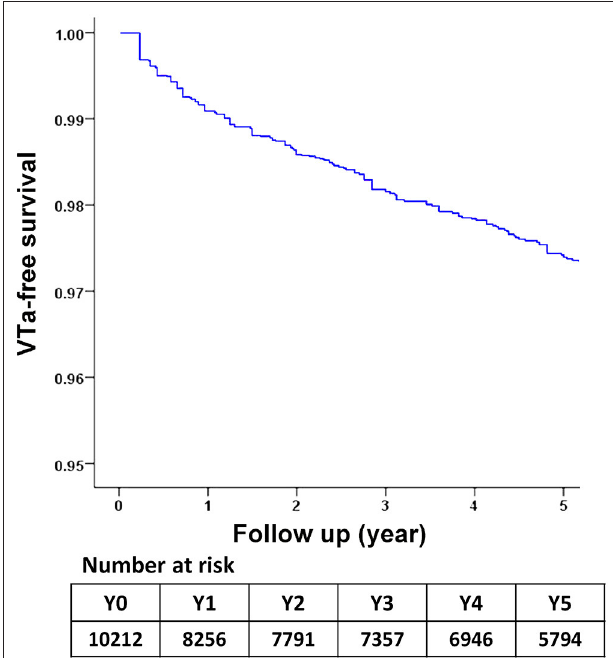
FIGURE 2 | The survival curve of freedom from VTa after surgical valve replacement during 5-year follow-up. VTa, ventricular